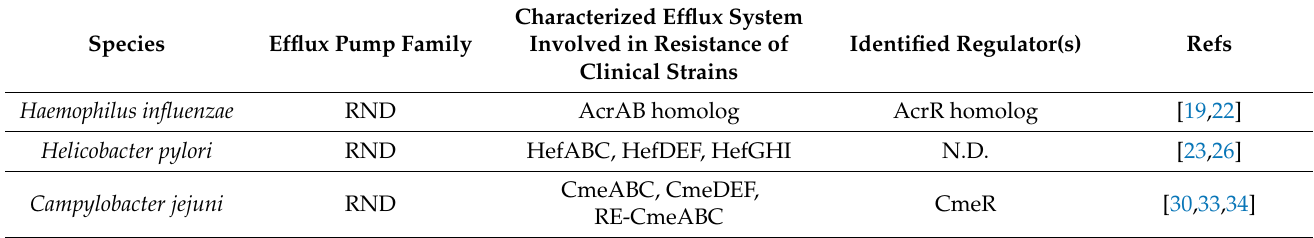
Table 1. The various pumps identified in Gram-negative clinical strains as involved in antibiotic resistance, N.D; (Not Determined).